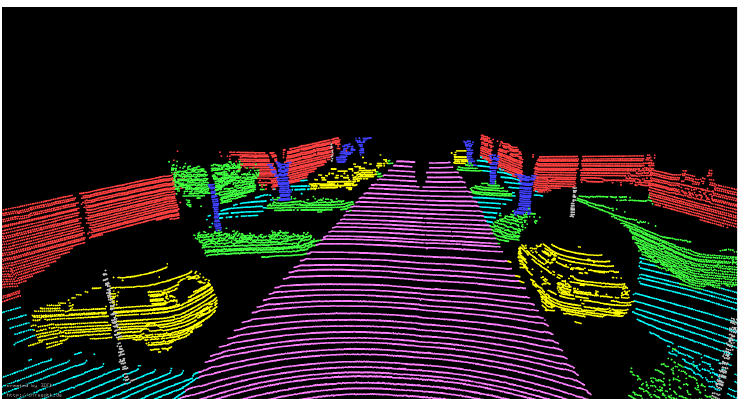
Figure 3. A single scan with semantic annotations in SemanticKITTI. Different colors represent different semantic attributes.